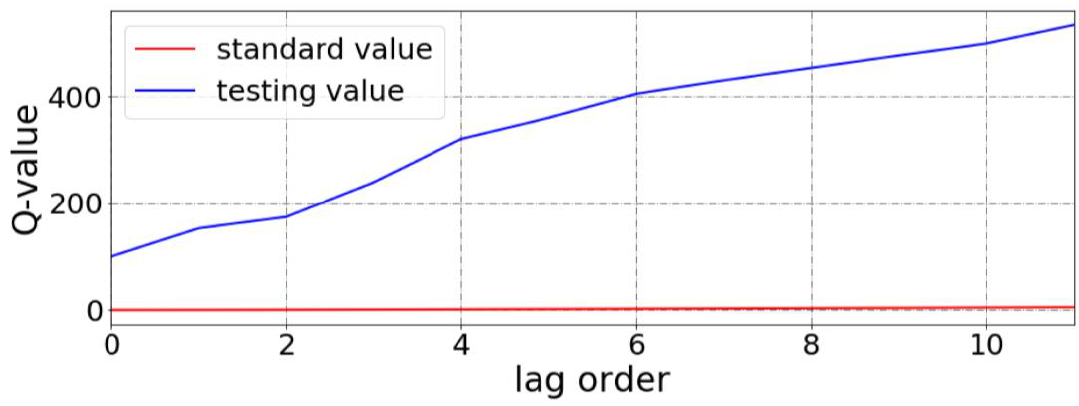
Figure 13. Box_Ljung value of each lag order.